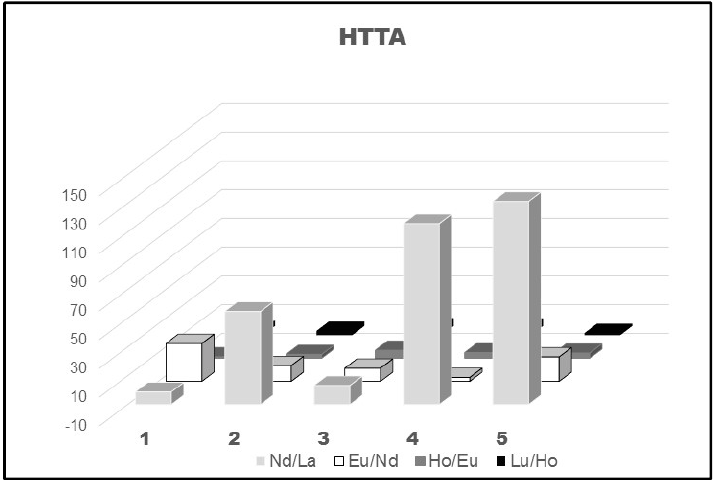
Figure 6. SFs of a few lanthanoid pairs using HTTA diluted in molecular diluents: 1-CHCl 3 ; 2-C 6 H 6 ; 3-C 2 H 4 Cl 2 ; 4-CCl 4 ; 5-C 6 H 12 , Table 4. Tendencies in the separation of the lanthanoids in their solvent extraction, implementing C 6 H 6 [45].